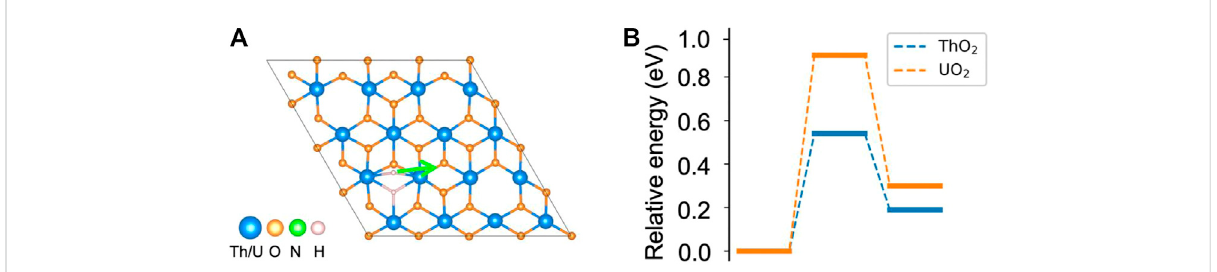
Migration of dissociated H − on ThO 2 and UO 2 surfaces. (A) Migration path of H − to a nearby site. (B) Corresponding energy diagram. The total energy of the initial state is set to zero.